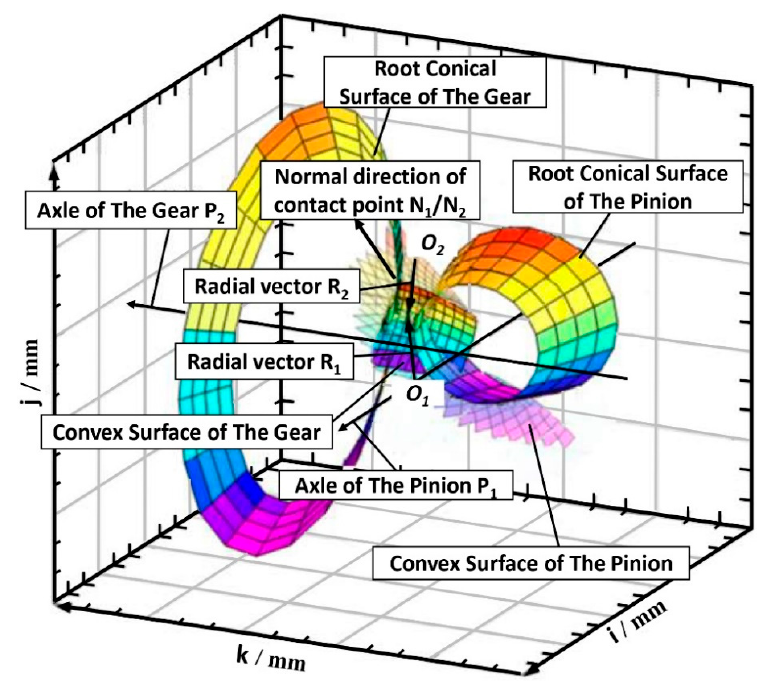
Figure 5. Contact Point Position of the spiral bevel gear pair surfaces.